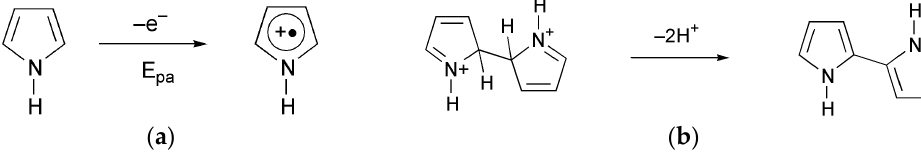
Figure 3. The schematic illustration of Py dimer’s synthesis: ( a ) formation of the cation radical R +• and ( b ) formation of the aromatic dimer. Reproduced from [88] with permission of The Royal Society of Chemistry.